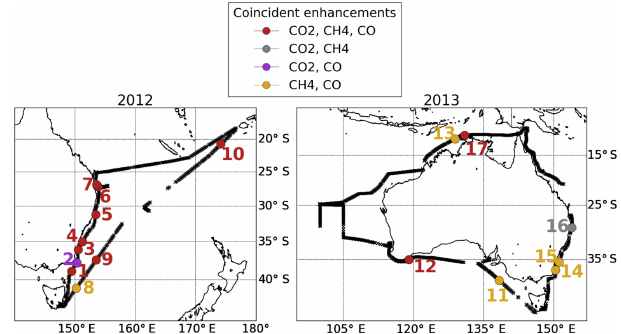
Figure 7. Location of the 17 events during which we observed co- enhancements of CO 2 , CH 4 and CO. The red numbers represent events with coincident enhancements in all three species, grey num- bers represent co-enhancements in CO 2 and CH 4 only, purple num- bers represent coincident enhancements in CO 2 and CO only, and yellow numbers represent coincident enhancements from CH 4 and CO only. The black line represents the measurement track during 2012 and